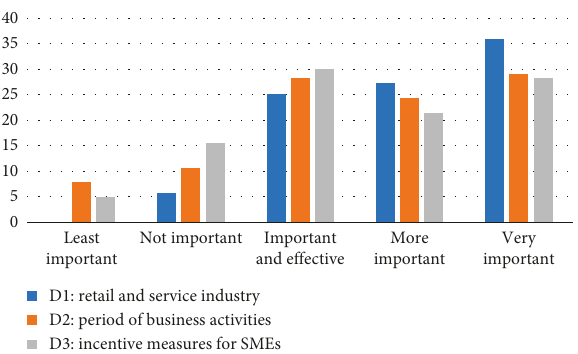
Figure 12: Evaluation of economic